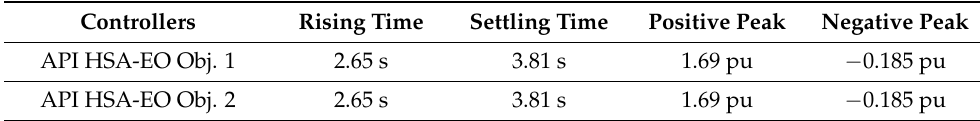
Figure 26. ( a ) (cid:1837) (cid:3043) adaptive PI gain of faulty first case. ( b ) (cid:1837) (cid:3036) adaptive PI gain of faulty first case. Figure 26. ( a ) K p adaptive PI gain of faulty first case. ( b ) K i adaptive PI gain of faulty first case. The numerical comparisons of the controllers are listed in Table 11. The two adaptive Table 11. Numerical comparison between the controllers at faulty first case. PI controllers have nearly same rising time, settling time, positive peak, and negative peak.